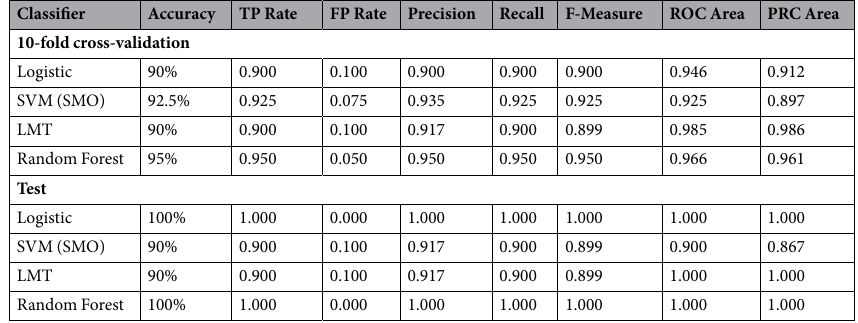
Table 6. The table reports the accuracies obtained from five different machine learning classifiers in the 10-fold cross-validation and in test set, using only normalized measures as predictors. In addition to accuracies, the table reports the weight average of True Positive Rate (TP Rate), False Positive Rate (FP Rate), Precision value, Recall value, F-Measure, Receiver Operating Characteristics (ROC) Area value and Precision-Recall Curve (PRC) Area